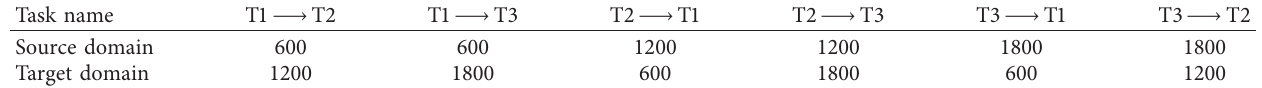
Table 4: Rotating speeds in the domain adaptation tasks (unit: rpm).